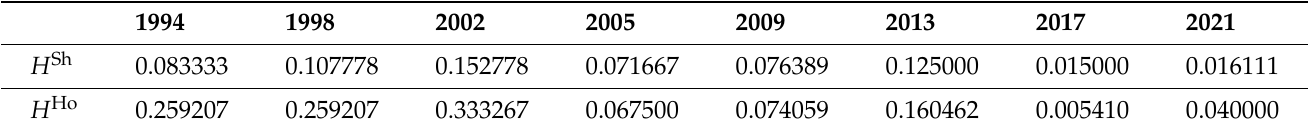
Table 4. Results for German federal parliament 1994–2021,